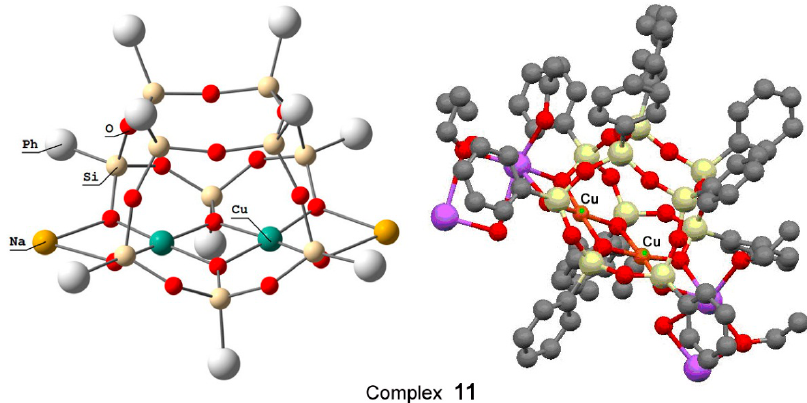
Figure 5. The structure of compound [(PhSiO 1.5 ) 10 (CuO) 2 (NaO 0.5 ) 2 4EtOH] ( 11 ) (left) and a fragment of polymeric structure (right). Adapted from Ref. [221].